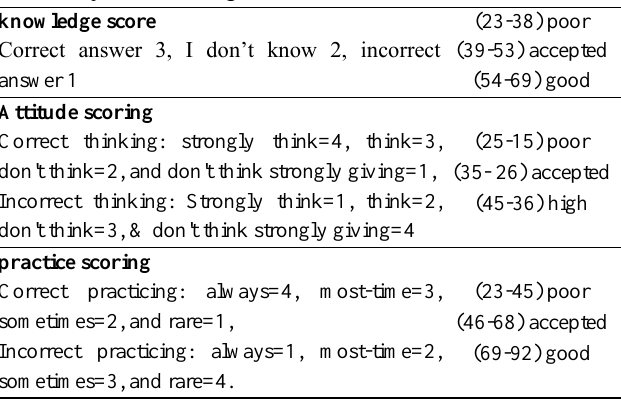
Table 1: Socio-demographic and baseline characteristics of